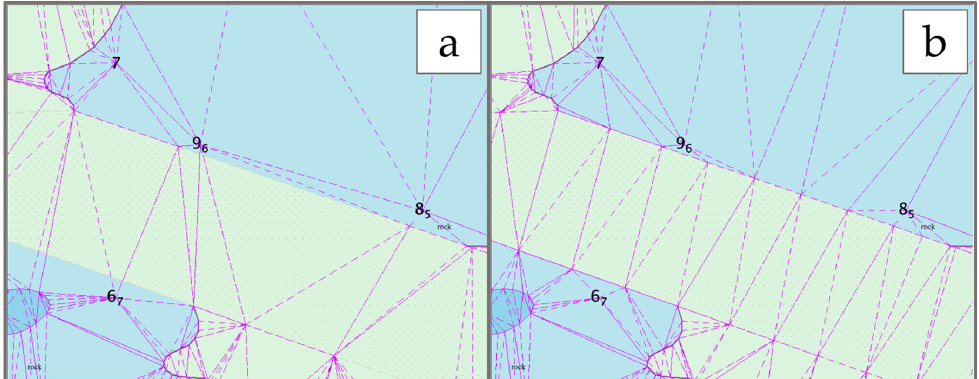
Figure 3. Pane ( a ) shows an example retrieved from an ENC where the long sides of a dredged-area feature (visualized with a dotted pattern) trigger the creation of triangles (dashed magenta lines) that overlap with the same feature edges. After the application of the proposed interpolation criterion, the resulting triangulation shown in pane ( b ) does not present the overlap issue.